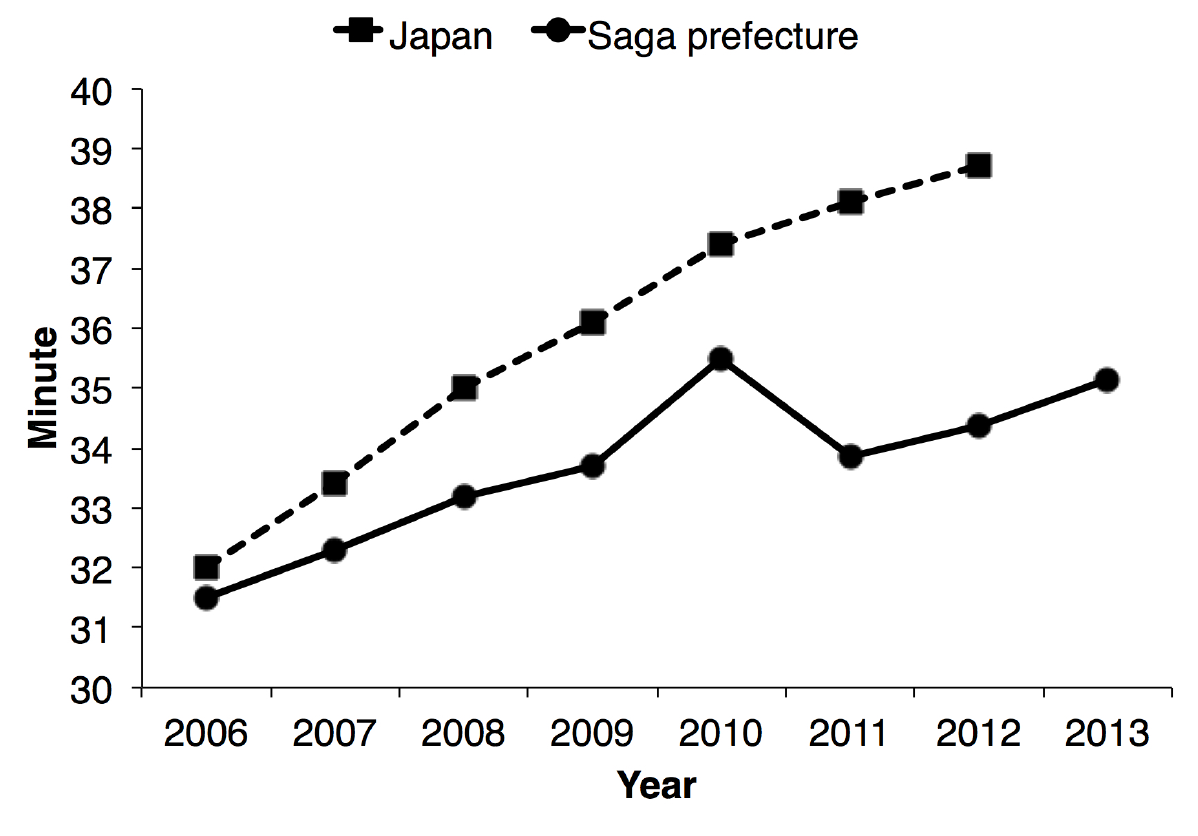
Figure 5. Mean transportation time in minutes in all of Japan and Saga